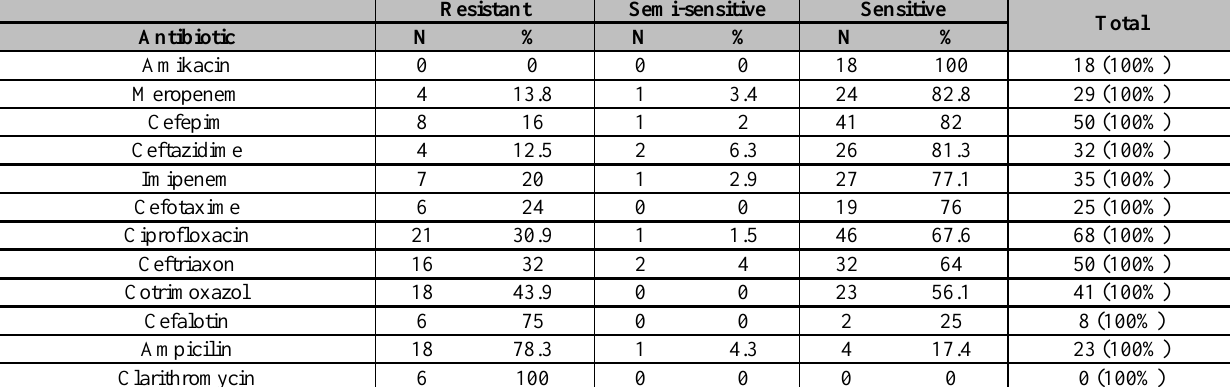
Table 2. The frequency distribution of Klebsiella pneumoniae susceptibility based on gender Gender Woman Man Semi- Resistant Sensitive sensitive Amikacin 100